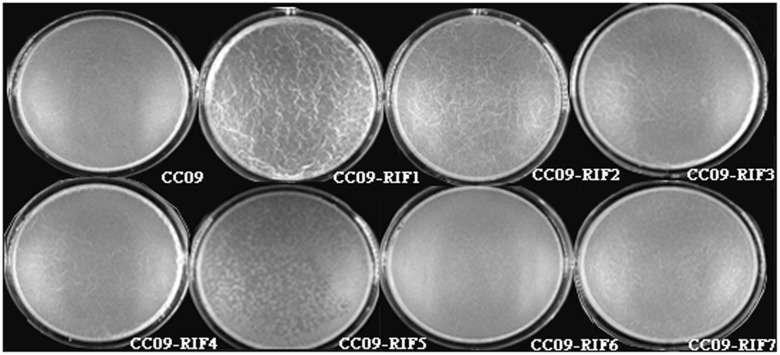
Appearance of the pellicle of the WT strain and Rifr mutants at 16 h after inoculation.